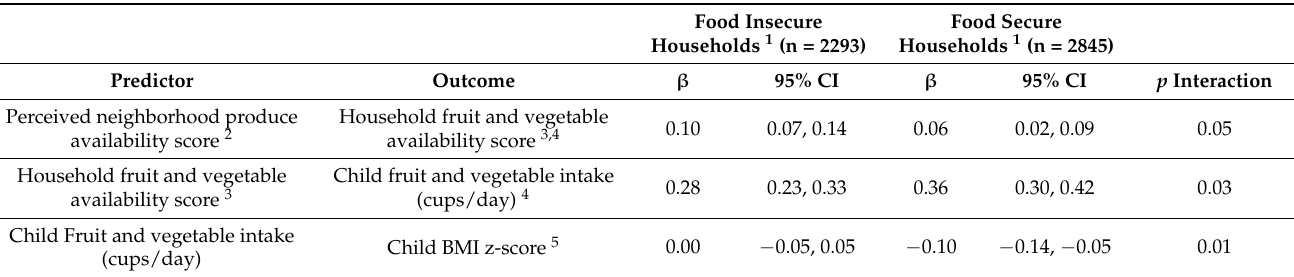
Table 3. Select relationships between perceived neighborhood produce availability, household fruit and vegetable availabil- ity, child fruit and vegetable intake, and child body mass index z-score (BMI z-score) in the Healthy Communities Study, by household food security status (N = 5138).